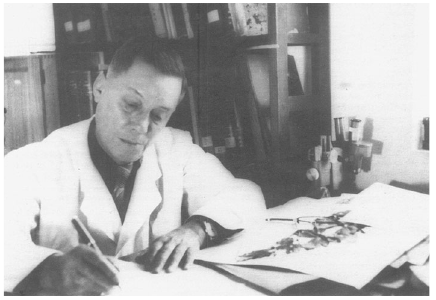
Figure 1. Prof. Huan-Yong Chen at work in 1956 in Guangzhou.